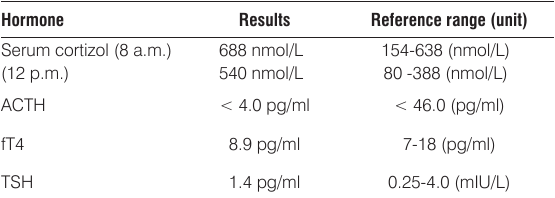
Table 1. Results of pituitary and end organ hormone tests. ACTH - adrenocorticotropic hormone, TSH - thyroid-stimulating hormone, fT4 - free